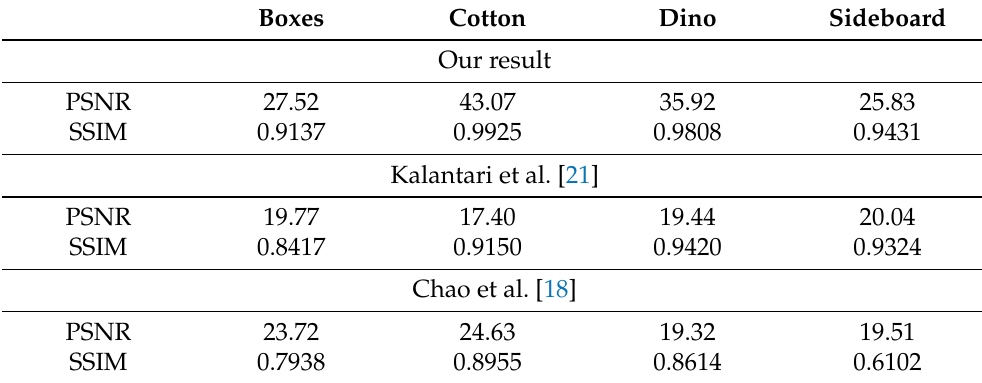
Table 6. Quantitative comparison for top left synthesized view comparison with different algorithms for images shown in Figure